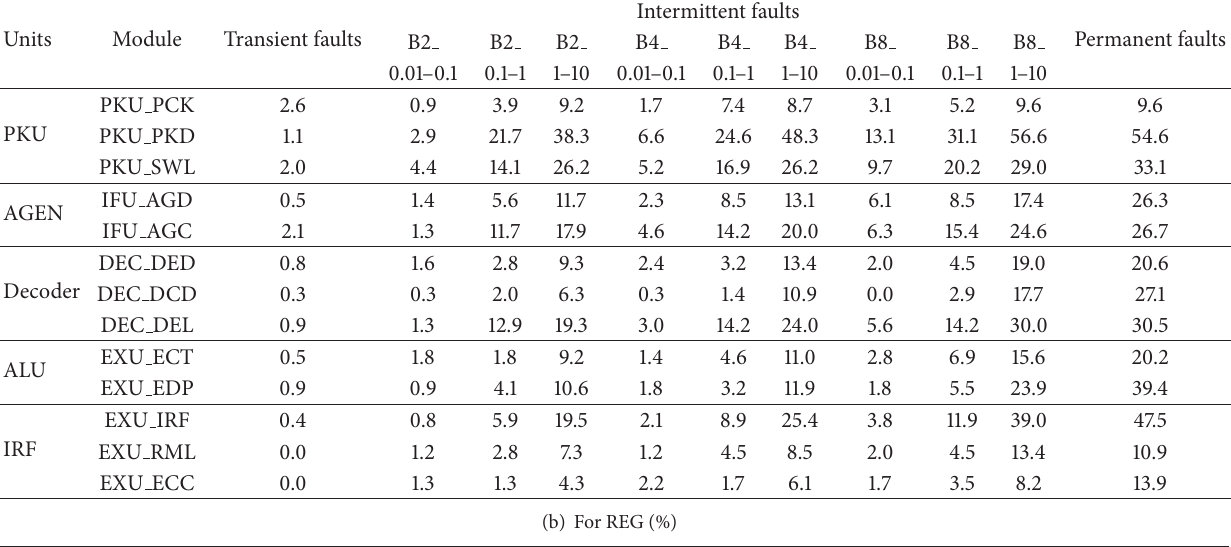
Table 6: Sensitivity breakup per unit for LDST workload ((a) for NET and (b) for REG). (a) For NET (%)